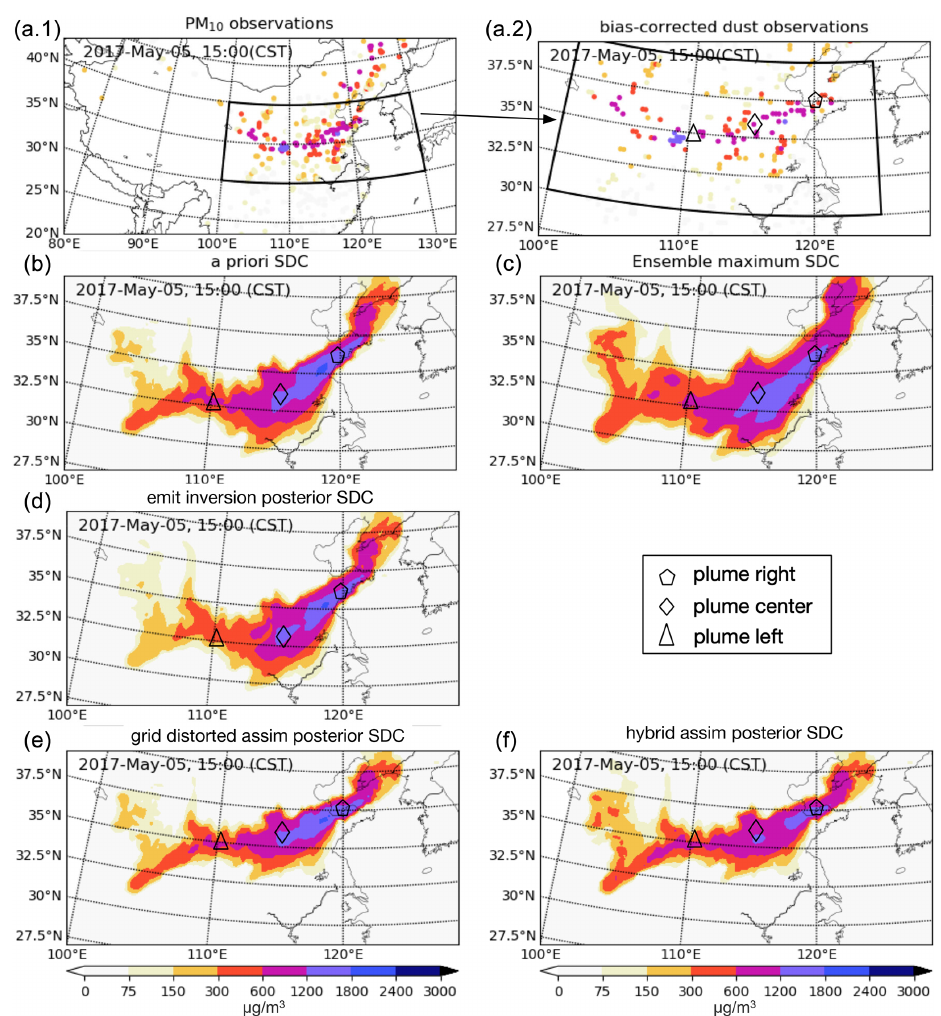
Figure 2. Original PM 10 (a.1) , bias-corrected dust observations (a.2) , the a priori surface dust concentration (b) , maximum over the ensemble simulations driven by ensemble meteorology (c) , posterior dust simulation of the emis inversion (d) , grid-distorted assim posterior (e) and hybrid assim posterior simulation (f) at 15:00CST on 5 May. SDC: surface dust concentration. Definitions of emis inversion, grid-distorted assim and hybrid assim can be found in Table 1.